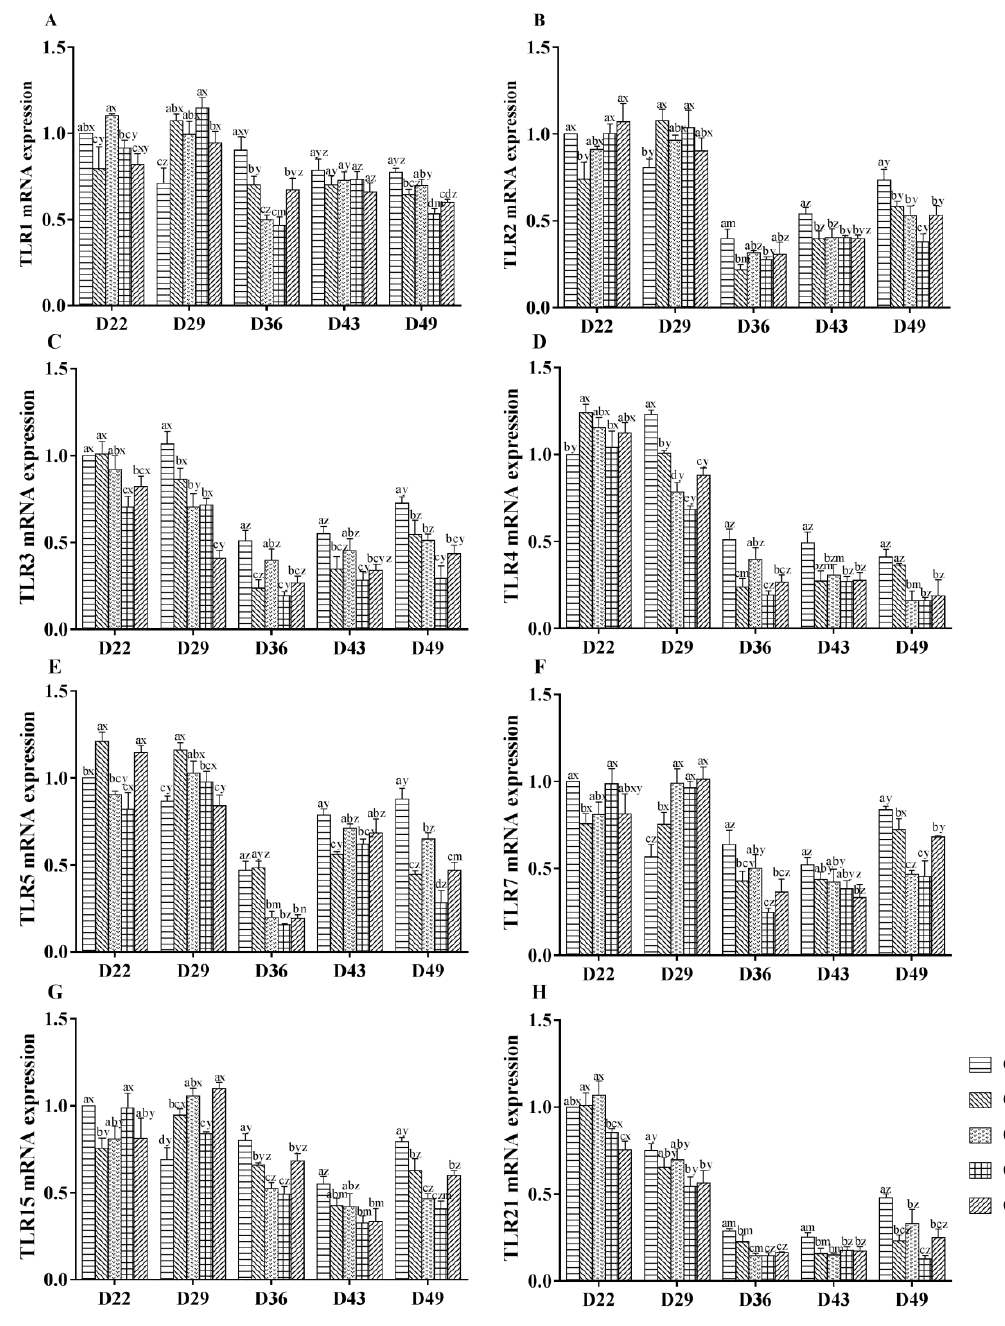
Figure 1. The mRNA expression levels of TLR1 ( A ), TLR2 ( B ), TLR3 ( C ), TLR4 ( D ), TLR5 ( E ), TLR7 ( F ), TLR15 ( G ), and TLR21 ( H ) in the bursae of broilers at D22, D29, D36, D43, and D49 (where D denotes “days of age” and the numeral indicates the day number, e.g., D22 refers to 22 days of age). a, b, c, d, and e represent significant differences among groups at the same sampling time ( p < 0.05). x, y, z, m, and n represent significant differences among different sampling time in the same group ( p < 0.05). CS3, CS4, CS5, and CS6 refered to the intermittent and mild cold stimulation of 3°C below the conventional feeding temperature for three-, four-, five-, or six-hour periods at one-day intervals, respectively.